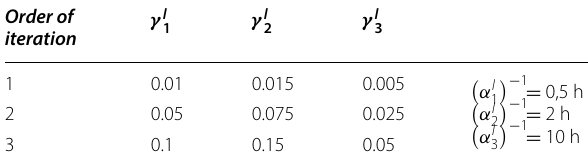
Table 5 Evolution and selection of the visco-elastic parameters